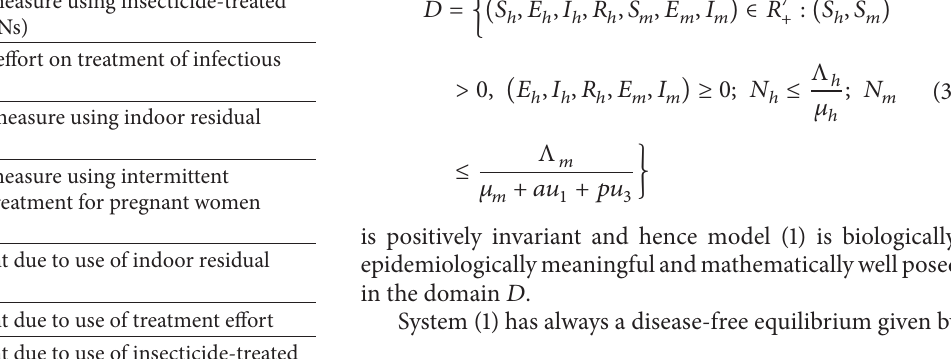
Table 3: Prevention and control variables in the model. Variable